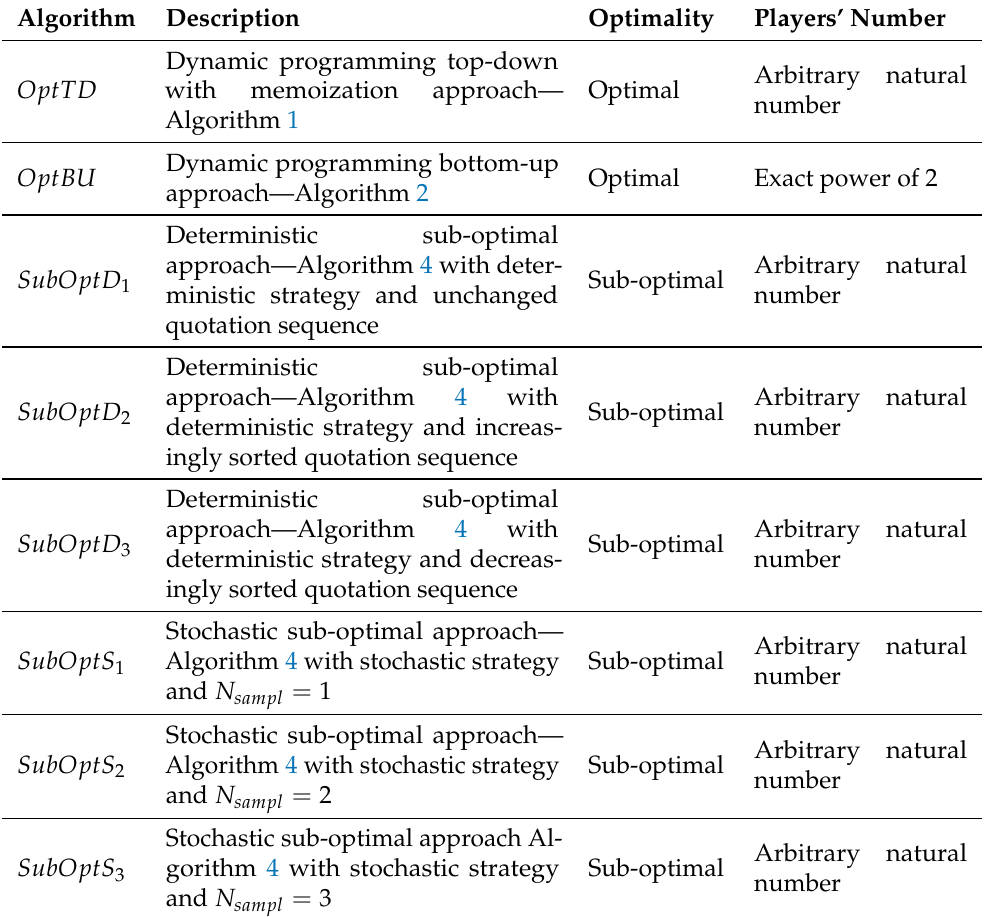
Table 4. Table presenting the list of implemented optimal and sub-optimal algorithms for bal- anced